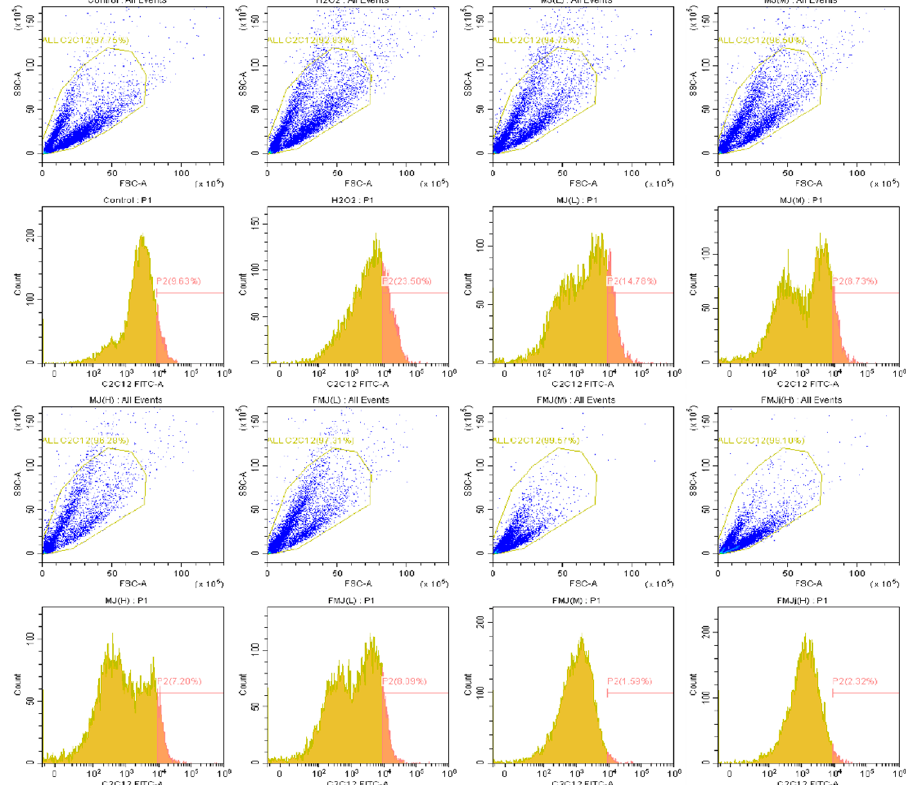
Figure 6. The inhibitory effect of BMJ and FBMJ on H 2 O 2 -induced intracellular ROS production in C2C12 cells. The intracellular ROS production was determined using the DCFH-DA method with flow cytometry.